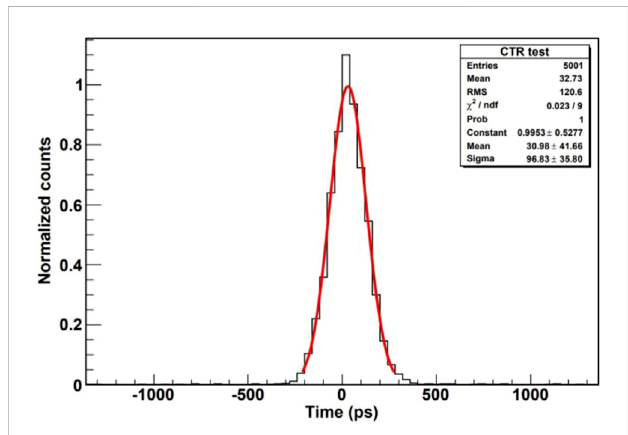
The CTRspectrum at2 mVthresholdbasedontheRFtransformer- based scheme.